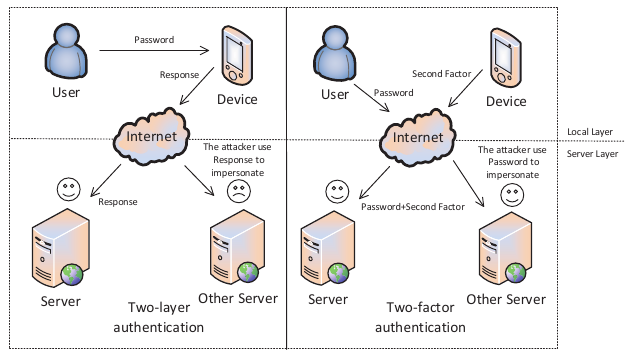
Figure 3. Two-layer authentication and two-factor authentica- tion. In two-layer authentication, the attacker intercepts the response which successfully authenticated and impersonates the user to the server, due to the expiry of OTP, the login request is denied and the attack is failed. In two-factor authentication, the attacker intercepts the static password and impersonates the user to the server which do not employ two-factor authentication. Due to the reuse of password, the login request is accepted and the attack is